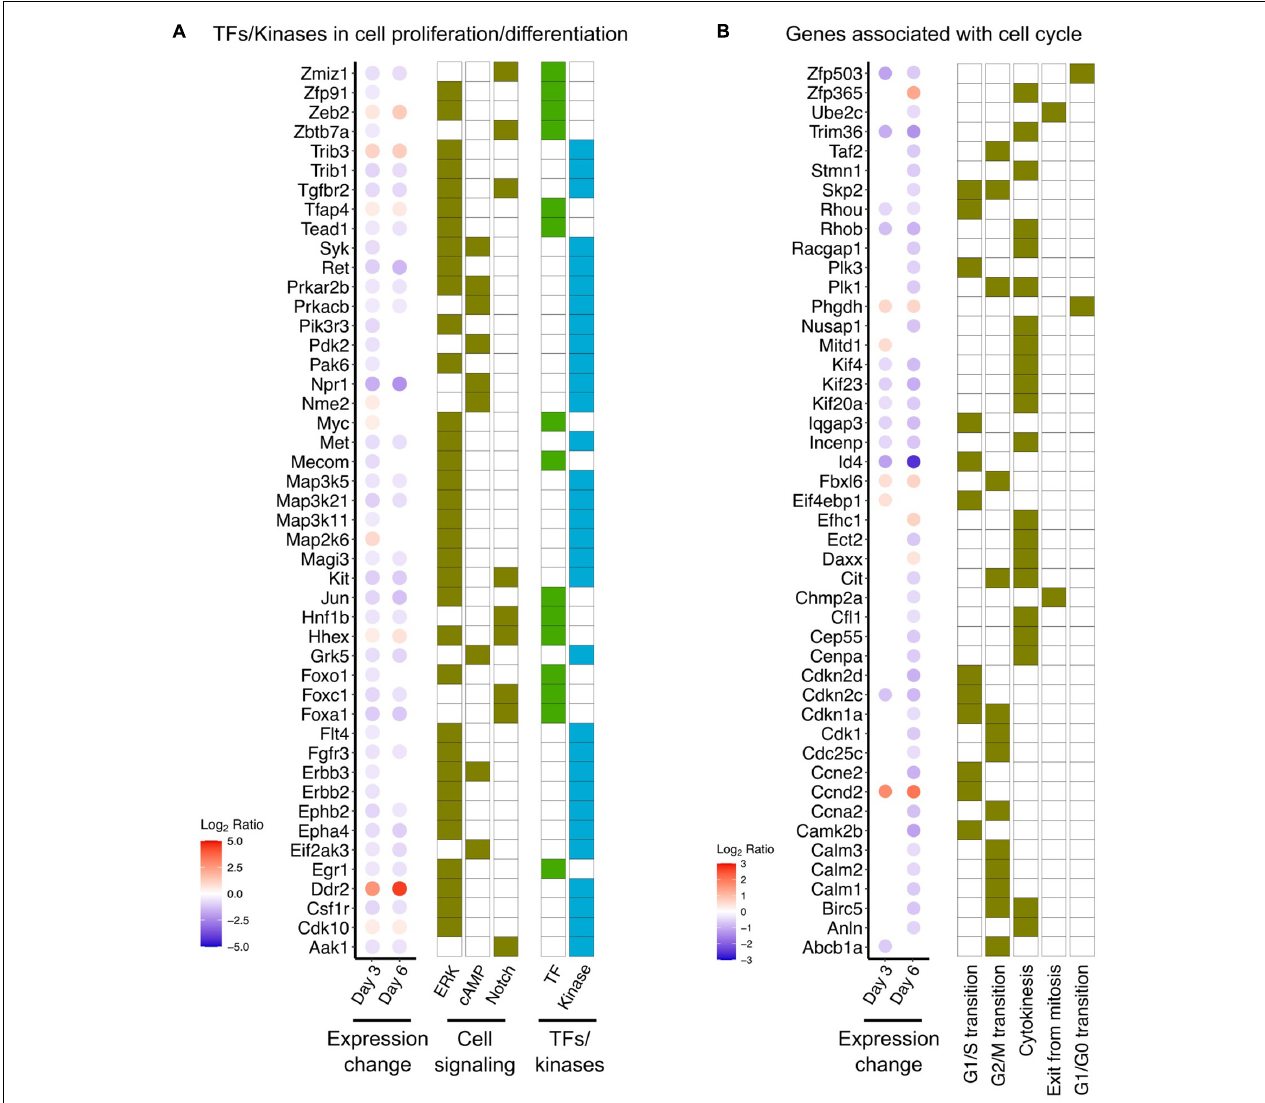
FIGURE 3 | DOX-responsive genes associated with cell proliferation and differentiation. (A) DOX-responsive expressional change of transcription factors (TFs) and protein kinases in three signaling pathways (ERK, cAMP, and Notch). Full list of DOX-responsive genes involved in these signaling pathways was provided in Supplementary Table 3 . (B) Expressional change of gene associated with cell cycle progression. Gene sets of each stage of cell cycle progression were obtained from Gene Ontology database (GO:0022402: cell cycle